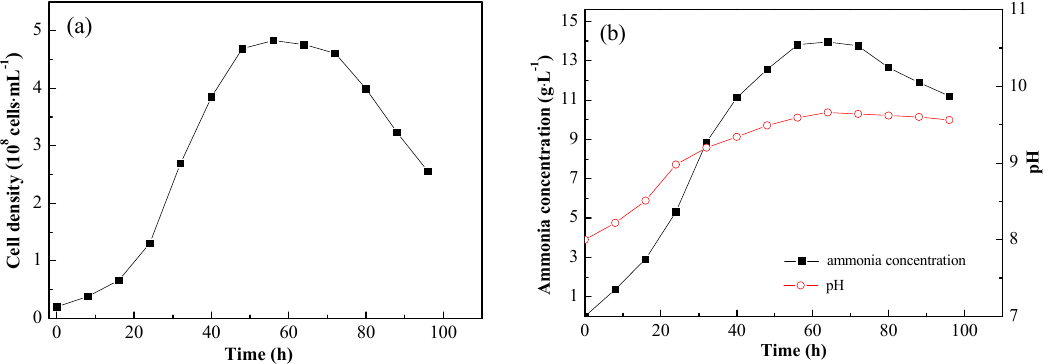
Figure 6. Pure culture of strain JAT-1 in urea medium: ( a ) Strain growth curve at optimal growth condition; ( b ) Variation of ammonia concentration and pH during growth.